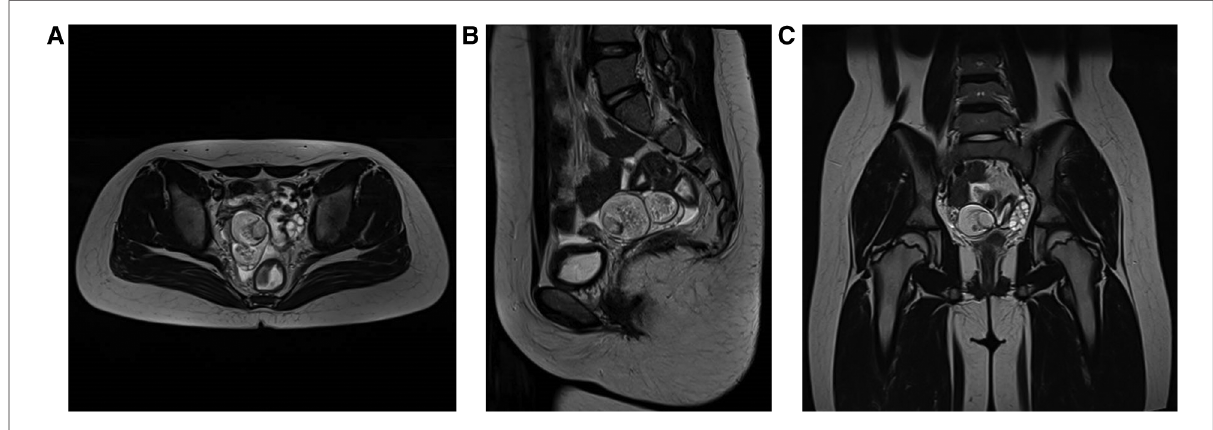
FIGURE 1 Representative preoperative MRI of patients: ( A ) horizontal plane, ( B ) sagittal plane, and ( C ) coronal plane. MRI indicated that the ovarian tumor was benign. MRI, magnetic resonance imaging.